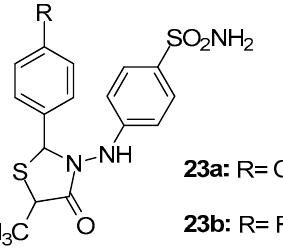
Figure 25. Chemical structures of thiazolidinone derivatives 23a , 23b .